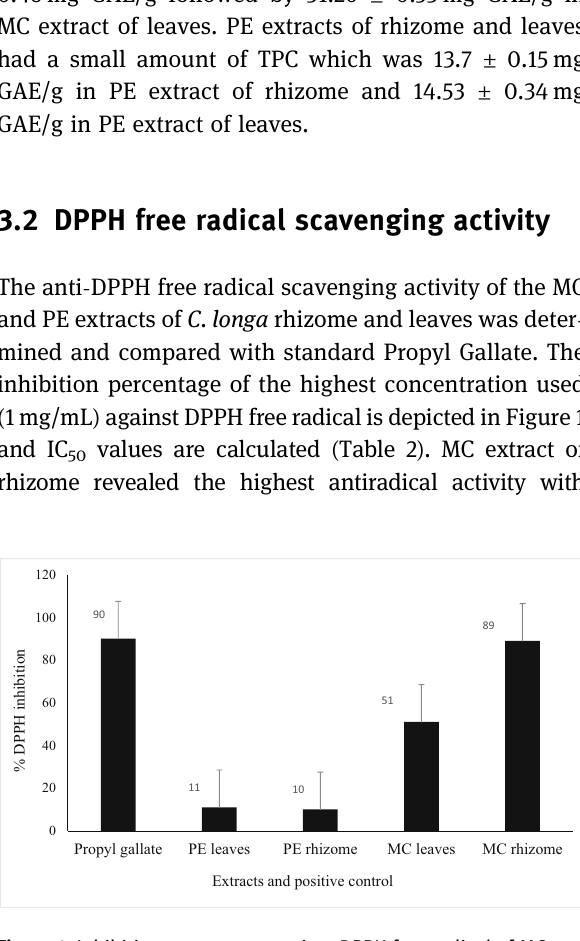
Figure 1: Inhibition percentage against DPPH free radical of MC and PE extracts of C. longa rhizome and leaves and standard propyl gallate at 1